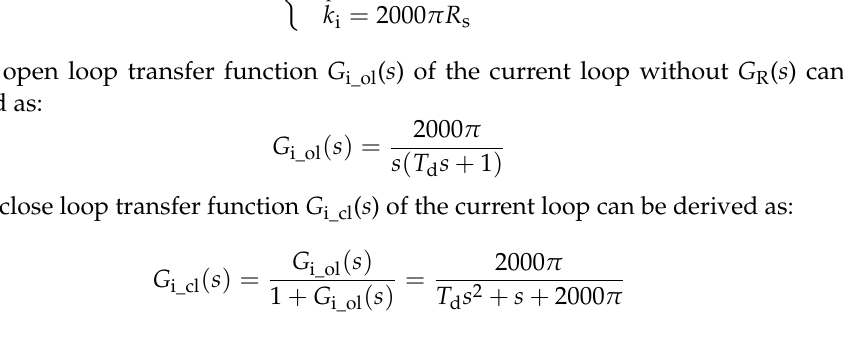
Figure 9. The control diagram of the current loop in d -axis.